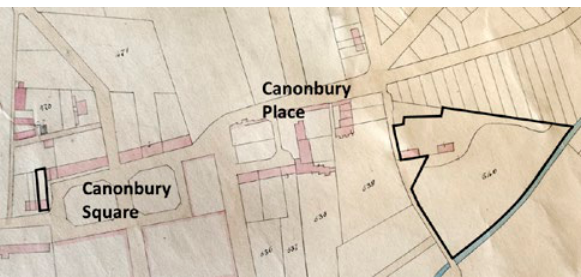
Figure 1. Locations of Ronalds’ two homes in Canonbury, Islington. Source: Titheable Lands in the Parish of Saint Mary Islington, 1849, London Metropolitan Archives DL/TI/A/029/A. By permission of the Bishop of London and the London Diocesan